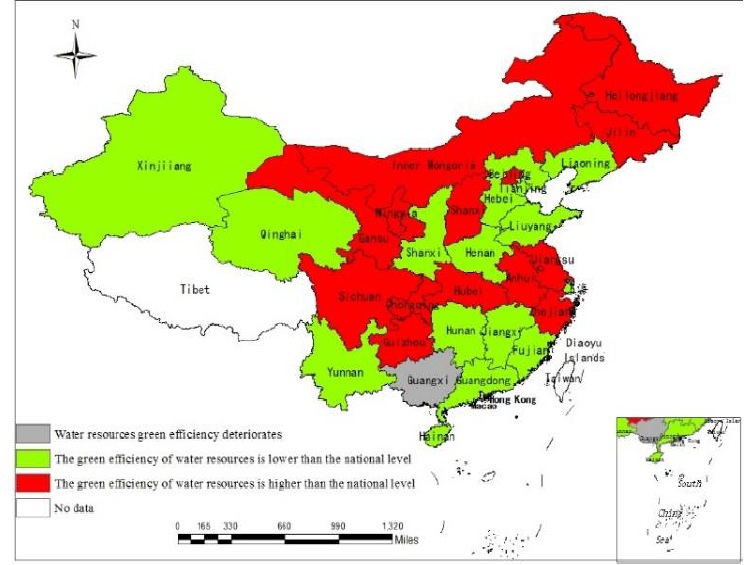
Figure 2. Average water resource green efficiency improvement (for the 2000–2016 study period) at the provincial level compared to that at the national level.